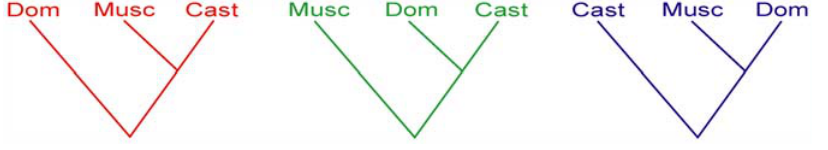
Figure 1. Three possible phylogenetic histories. The three possible phylogenetic relationships among subspecies of house mice are shown, rooted by